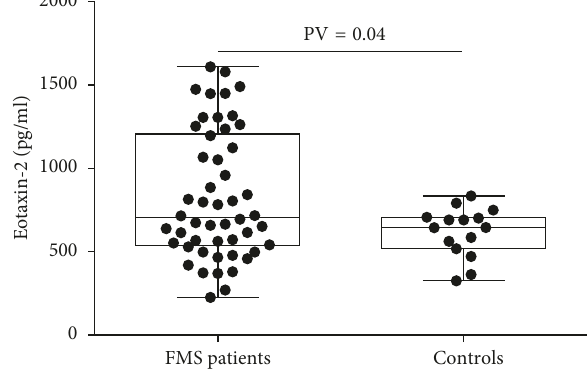
Figure 1: Eotaxin-2 levels in serum of patients with FMS and healthy